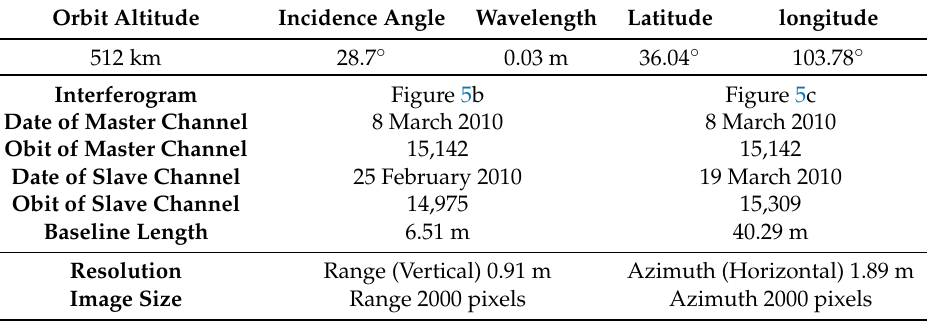
Table 4. Major Interferometric Parameters of Real DB Dataset of TerraSAR-X.